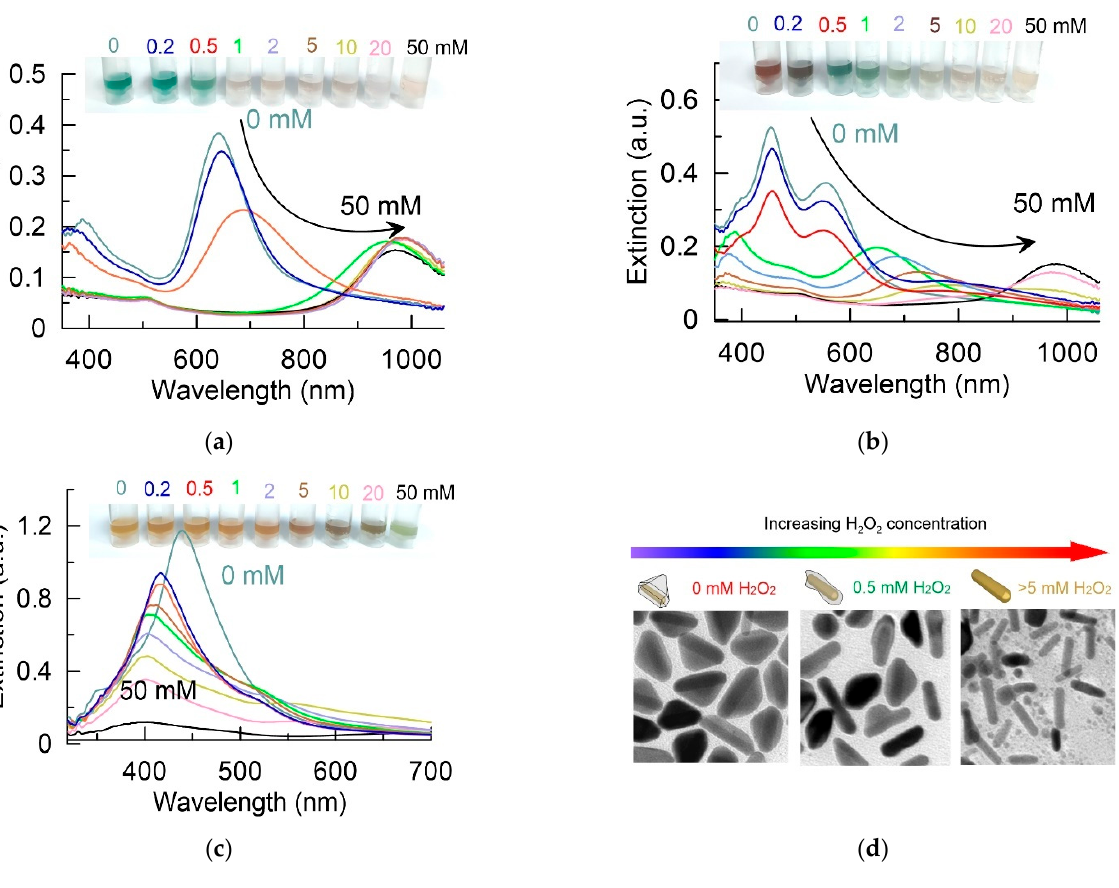
Figure 4. The change in Au@Ag nanoparticles extinction spectra as a function of the concentration of H 2 O 2 . The data are given for nanoparticles obtained using Ag-to-Au molar ratios 1.25 ( a ), 2.5 ( b ), and 5 ( c ). The insert shows images with nanoparticles colloids; ( d ) representative TEM images of Au@Ag nanoparticles before and after addition of H 2 O 2 to final concentrations of 0.5 and 5 mM.